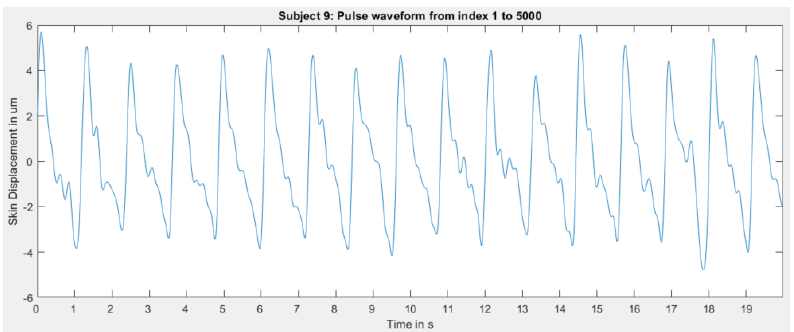
Figure 19. Extracted pulse waves for subject 9.